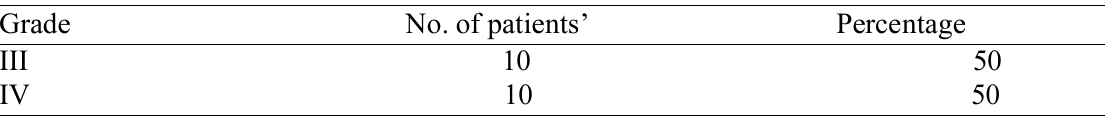
Table 4: Extent of comminution (W and H)